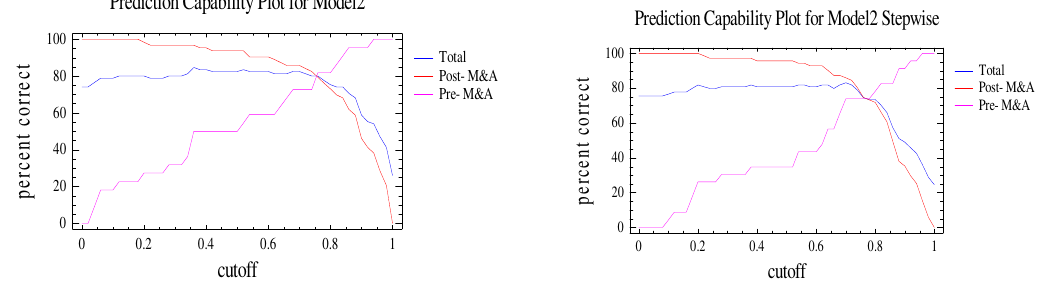
Fig. 2. Prediction capability plot using LR 2 (on the left-hand side) and LR 2 stepwise (on the right-hand side) for pre-post M&A